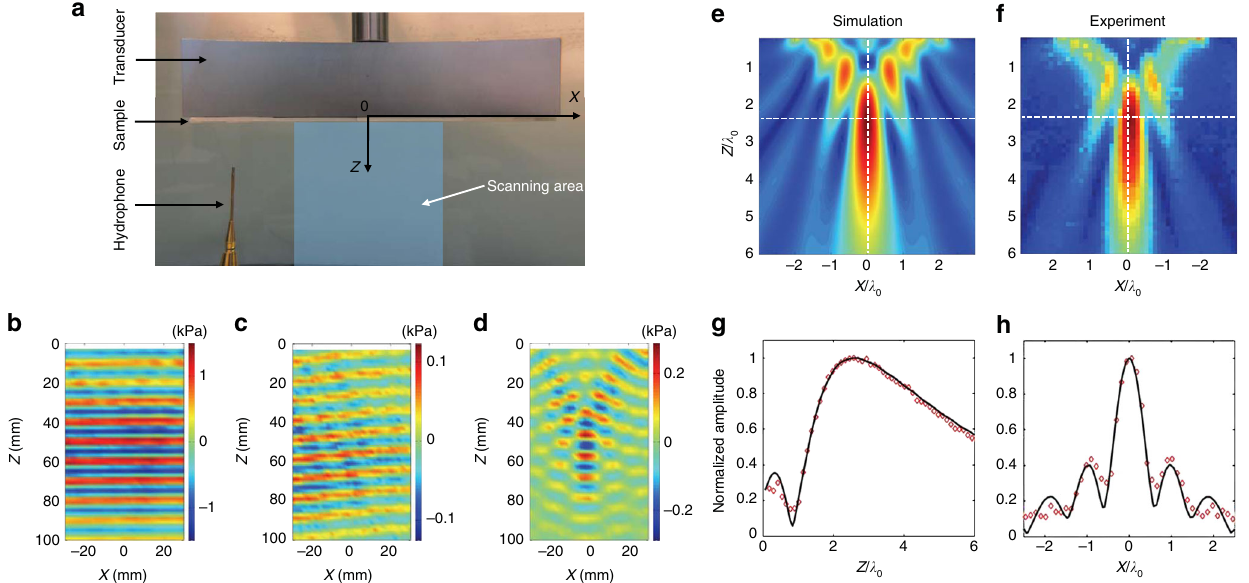
Fig. 2 2D de fl ecting and focusing of ultrasound. a Experimental setup showing a soft porous GRIN metasurface covering a large rectangular ultrasonic transducer immersed in a large water tank. A tiny hydrophone is mounted on motorized linear stages to scan the acoustic pressure fi eld in the XZ plane (60 mm × 100 mm) emerging from the metasurface (shaded blue area). b – d Snapshots of the measured pressure fi elds shown at a given time without any sample ( b ), with the de fl ecting metasurface ( c ), and with the focusing metasurface ( d ) (corresponding videos are shown in Supplementary Movies 1, 2 and 3). Simulated ( e ) and measured ( f ) acoustic fi eld patterns extracted from fast Fourier transforms performed at 90 kHz on the signals recorded for the focusing metasurface ( d ). Measured (red diamonds) and simulated (black line) normalized amplitude fi eld distributions along the Z -axis for X = 0 mm ( g ) and along the X -axis for Z = 44 mm ( h ). The full widths at half maximum peaks are 4.9 λ 0 and 0.8 λ 0 along the Z -axis and X -axis,